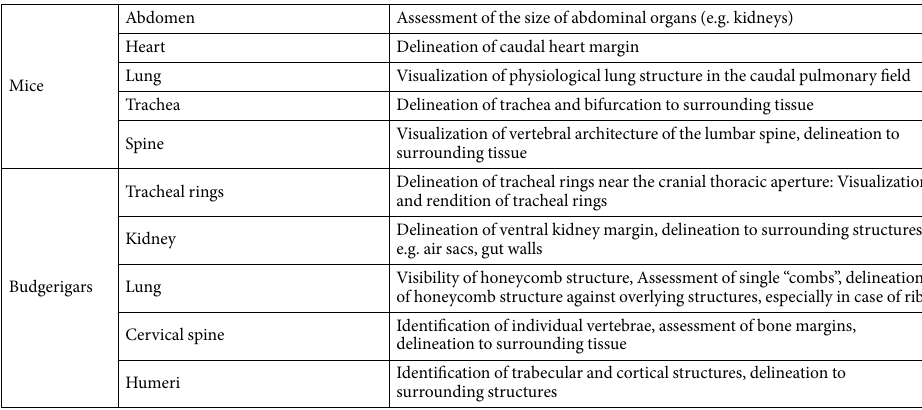
Table 2. Definition of criteria for radiographic assessment.